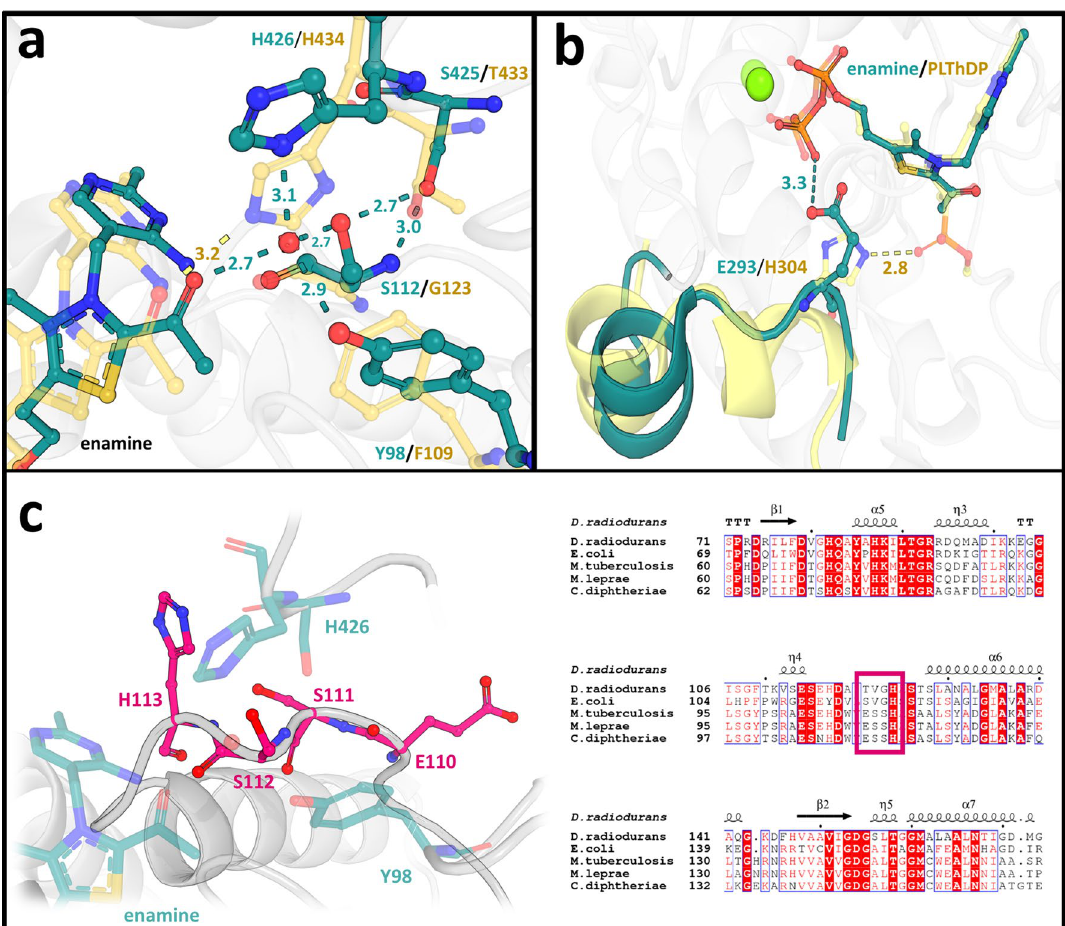
Figure 4. Comparison of drDXPS and MtDXPS enamine intermediate active sites. ( a ) Ser-network/H-bonds stabilizing the enamine intermediate. Residues from MtDXPS are colored in cyan, while the corresponding residues from drDXPS (PDB ID: 6OUW ) are colored in yellow. Hydrogen bonds are shown as dashed lines with distances in Ångström. ( b ) “Fork” motif. The “fork”-like motif found in the intermediate structure is highlighted in cyan, the similar motif in drDXS is colored in yellow. The key difference is the presence of Glu293 in the MtDXPS structure. ( c ) ESSH sequence motif. The ESSH sequence motif found in the ∆MtDXPS structures is shown in pink. The table shows the sequence alignment of bacterial DXPS, with several sequences bearing the ESSH sequence motif shown for representation, highlighted with a pink